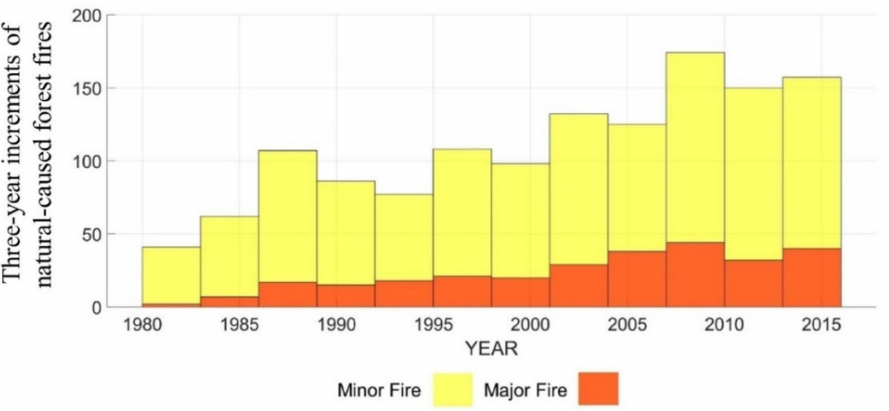
Figure 3. Three-year increments of natural-caused forest fires over the historical period (1980–2015) in western U.S.